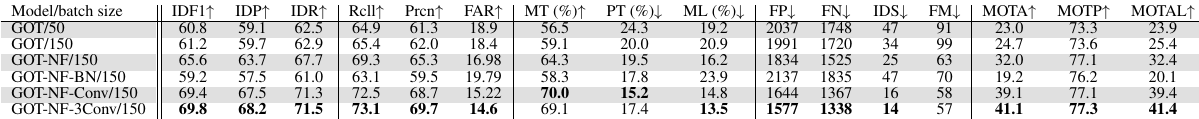
Model/batch size